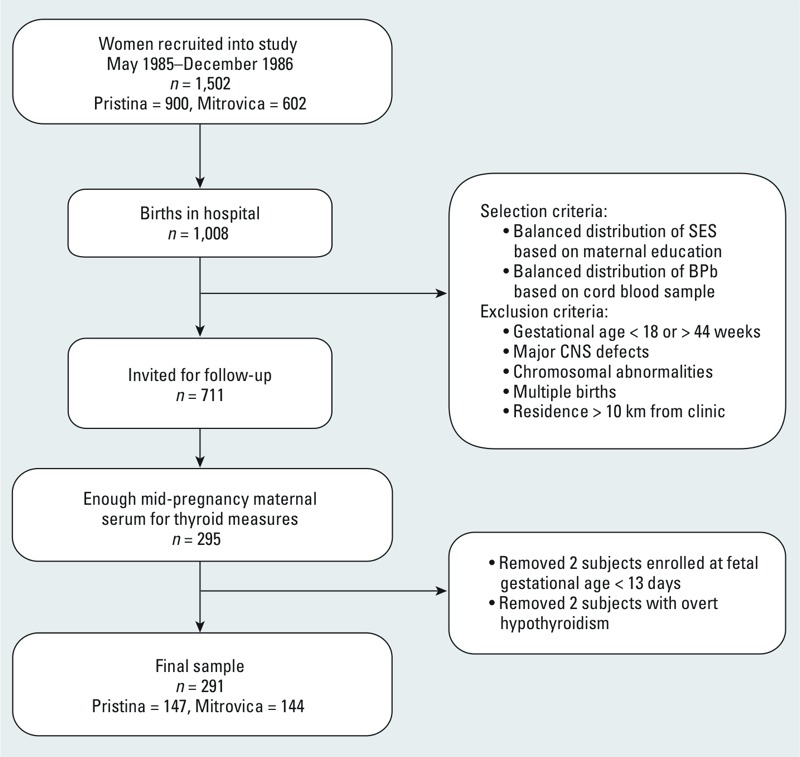
Recruitment and participation of study subjects. Abbreviations: CNS, central nervous system; SES, socioeconomic status.